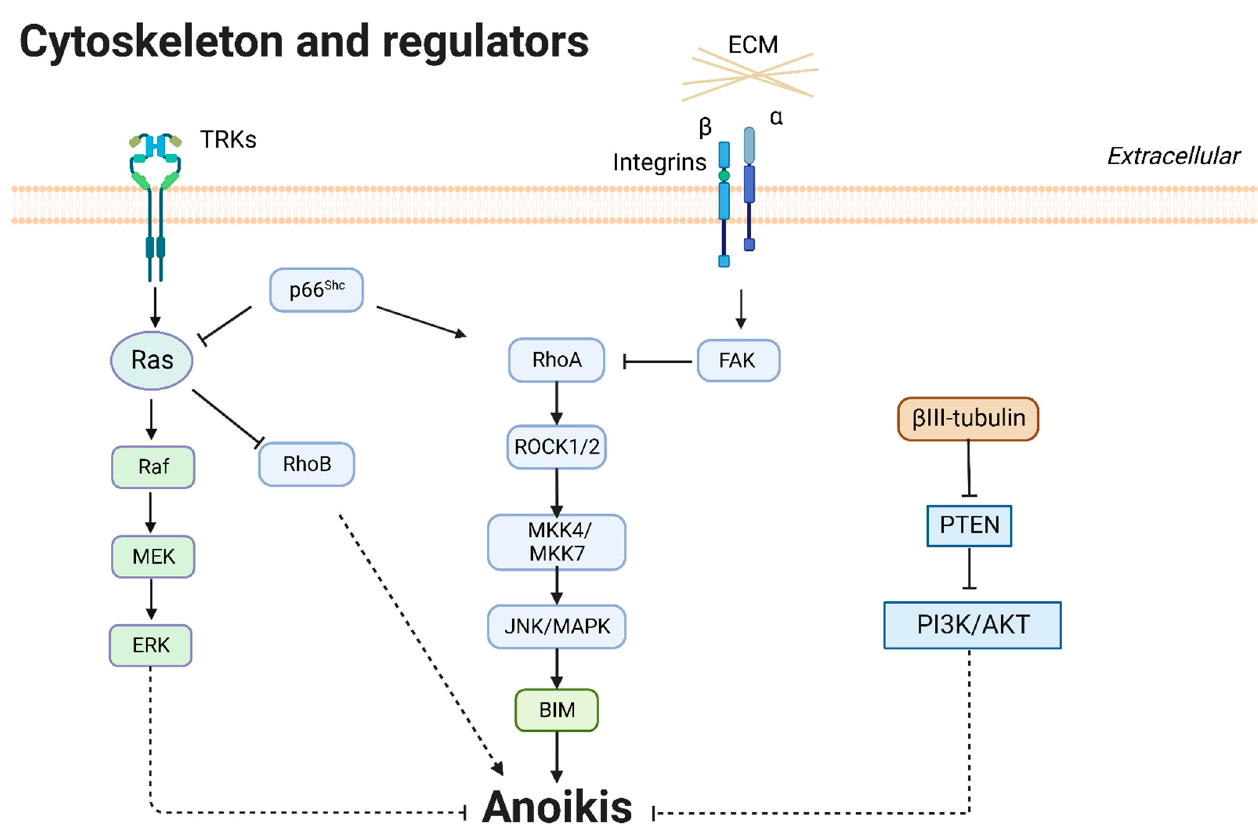
Figure 4. Cytoskeleton and regulators in anoikis.